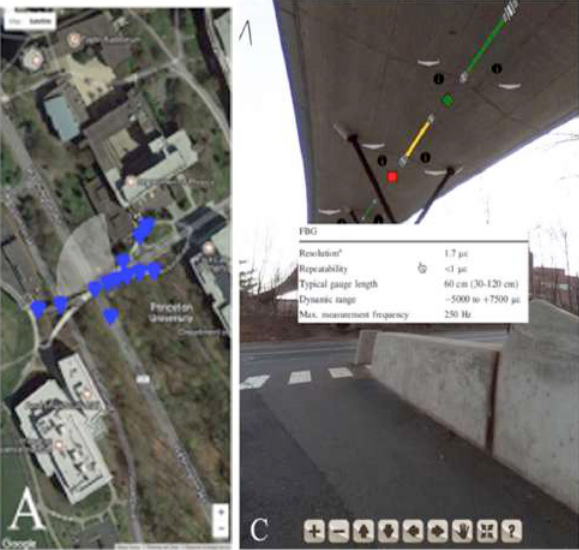
Figure 6. VT interactions ( A ) thermal change; ( C ) strain sensor metadata (R. Napolitano, G. Scherer, B. Glisic, 2017)